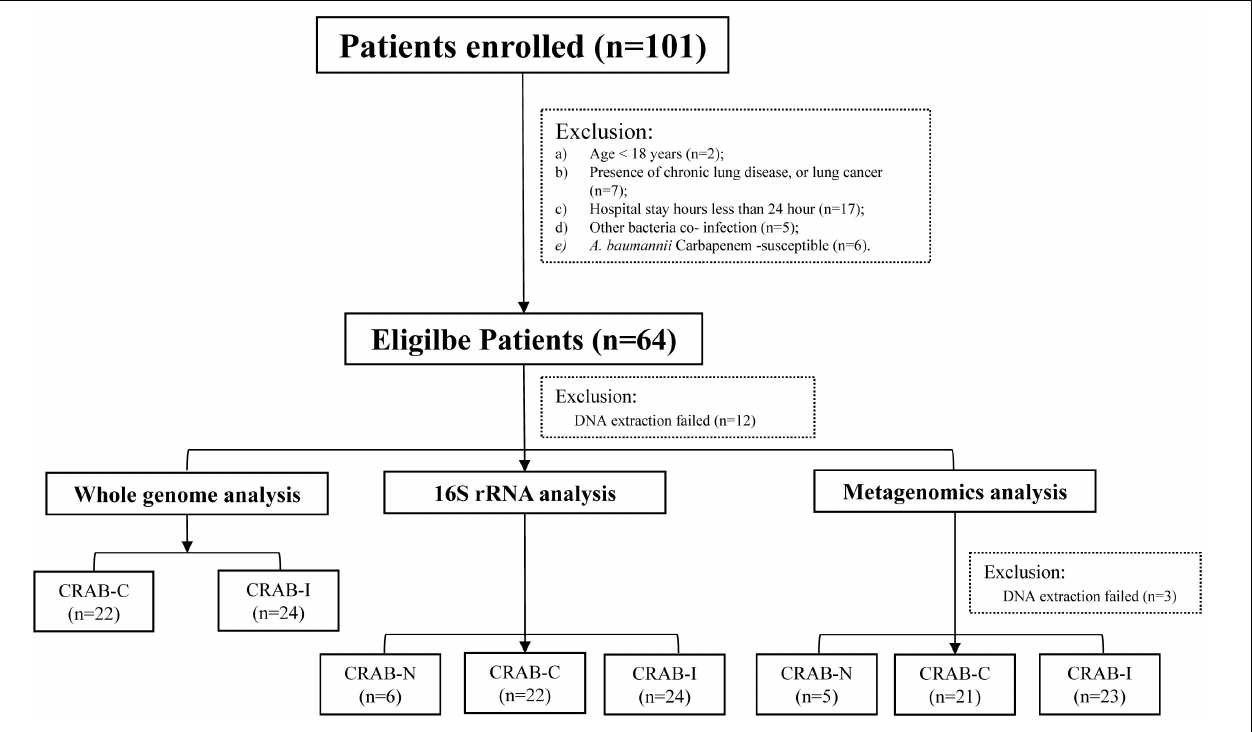
FIGURE 1 | Flowchart of the patient enrollment process.